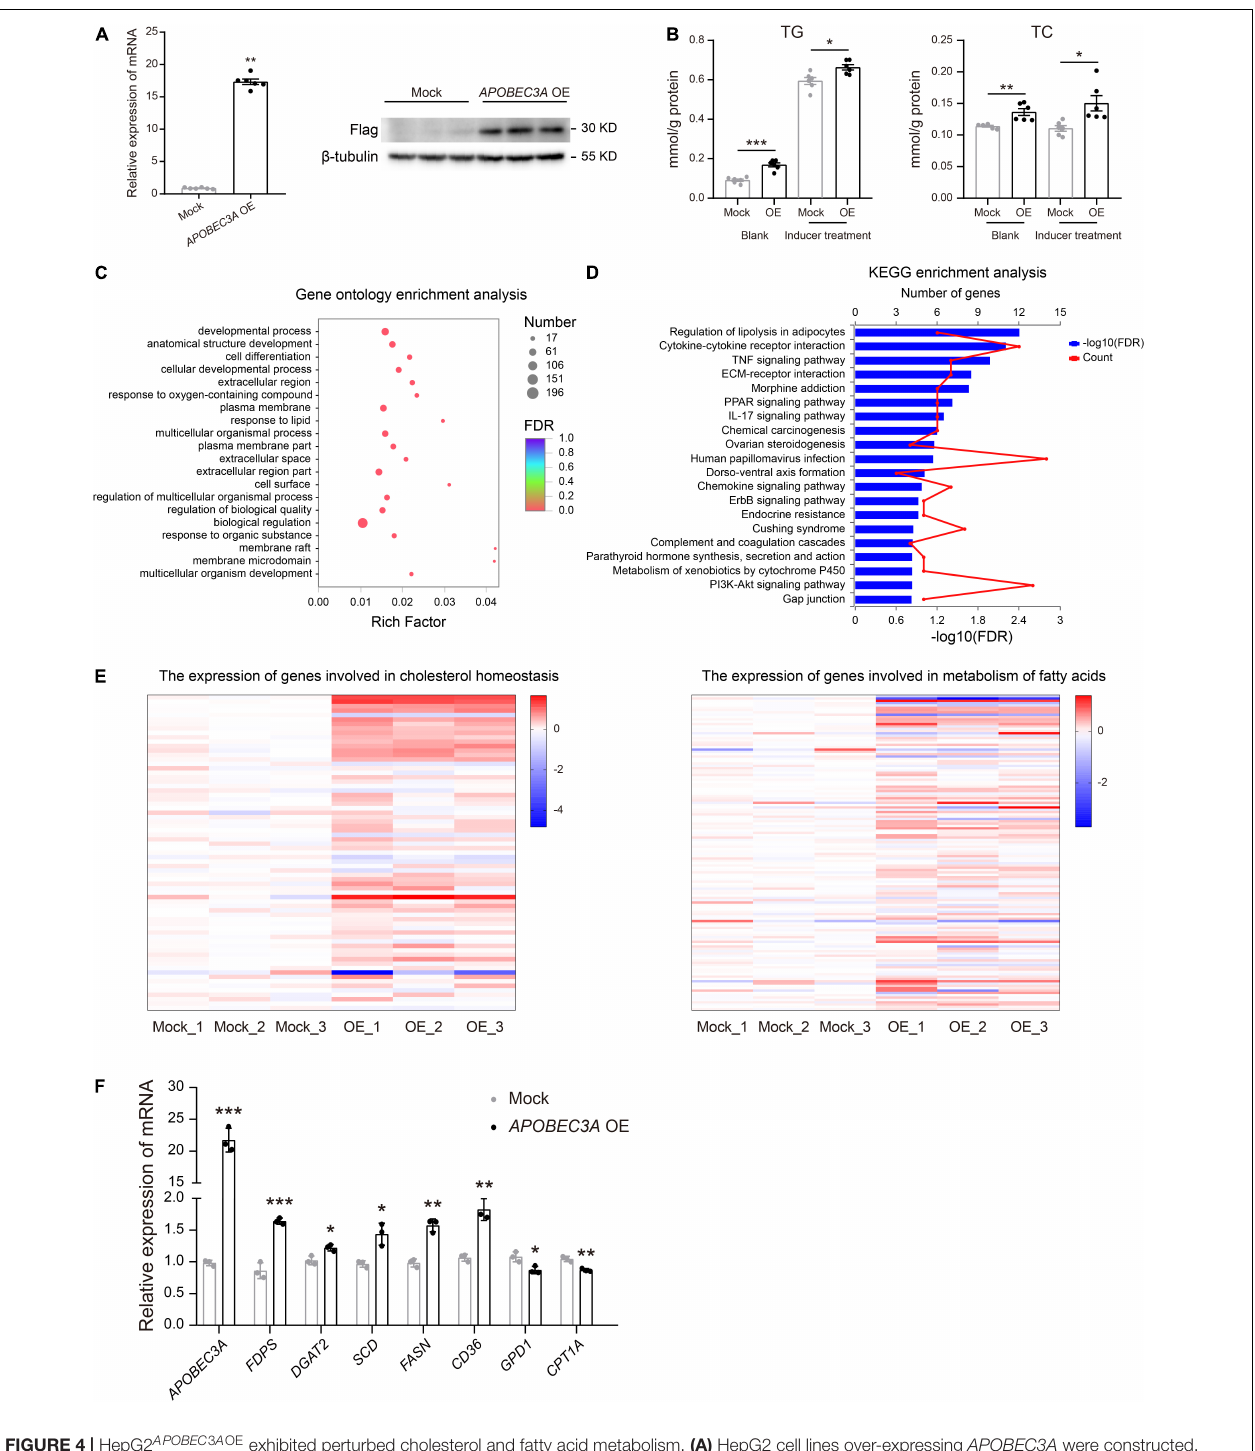
FIGURE 4 | HepG2 APOBEC 3 A OE exhibited perturbed cholesterol and fatty acid metabolism. (A) HepG2 cell lines over-expressing APOBEC3A were constructed. (B) TG and TC levels in the lysates of HepG2 APOBEC 3 A OE and mock cells ( n = 6/group). (C) Differential genes between HepG2 APOBEC 3 A OE and mock cells were enriched in functions of respond to lipid. (D) Differential genes between HepG2 APOBEC 3 A OE and mock cells were enriched in pathways of the regulation of lipolysis in adipocytes. (E) The expression of genes connected with cholesterol homeostasis and metabolism of fatty acids in HepG2 APOBEC 3 A OE and mock cells ( n = 3/group). (F) The mRNA expression of multiple genes related to cholesterol and fatty acid metabolism in HepG2 APOBEC 3 A OE and mock cells ( n = 3/group). The unpaired two-tailed Student’s t -test determined statistical significances between two groups. Data were represented as the mean ± SEM. *** P < 0.001, ** P < 0.01, * P < 0.05. OE, HepG2 APOBEC 3 A OE cells; Mock, HepG2 mock